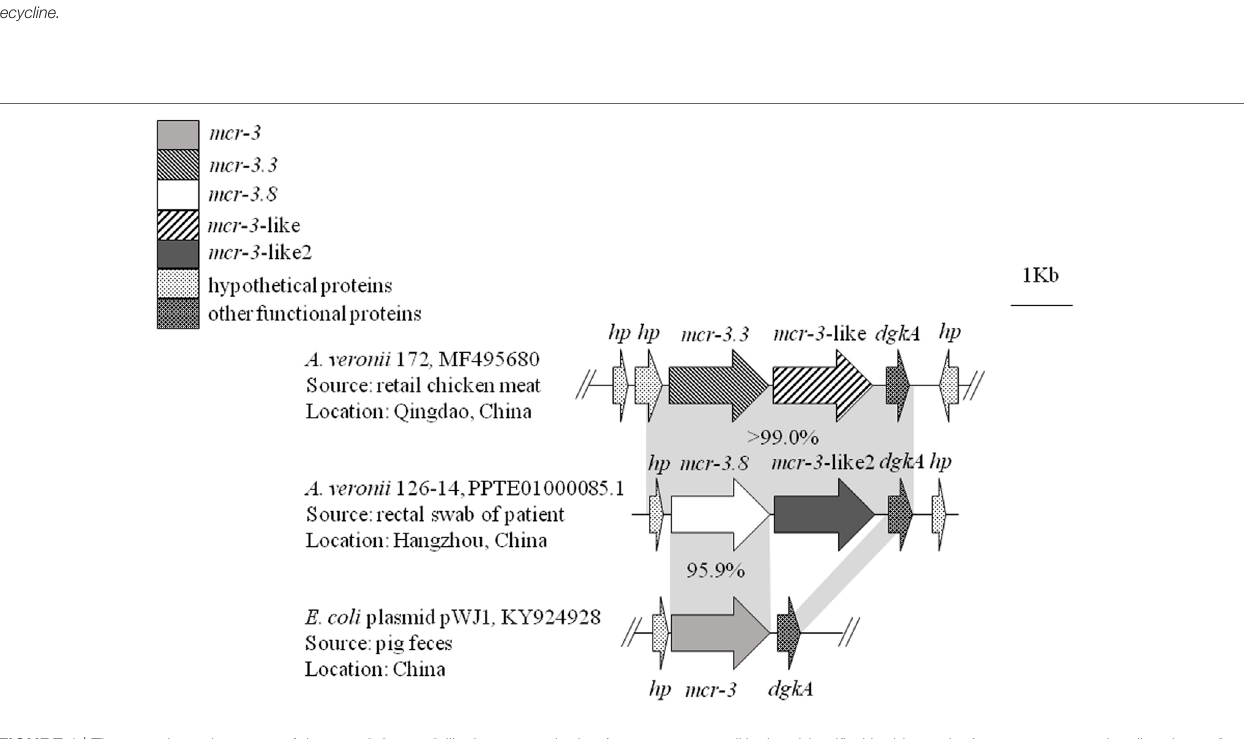
FigUre 1 | The genetic environment of the mcr-3.8-mcr-3- like2 segment in the Aeromonas veronii isolate identified in this study. Arrows represent the directions of the genes. Gray shading indicates two areas with significant